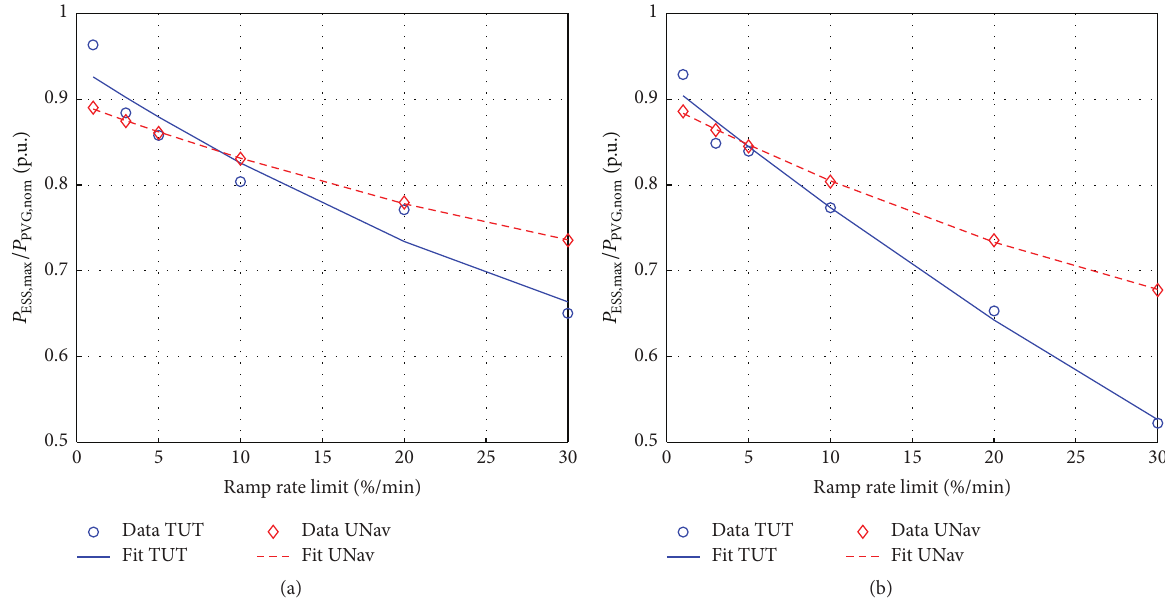
Figure 8: Simulated ESS maximum power requirements as functions of the ramp rate limit for (a) the 0.55 MWp and (b) 2.2 MWp PV generators. Values have been normalized to the generators nominal power. Overall trends have been depicted with the second-order polynomial fits. The results obtained by the researchers at the University of Navarra for corresponding PV generators located in western Spain are shown for comparison [9].